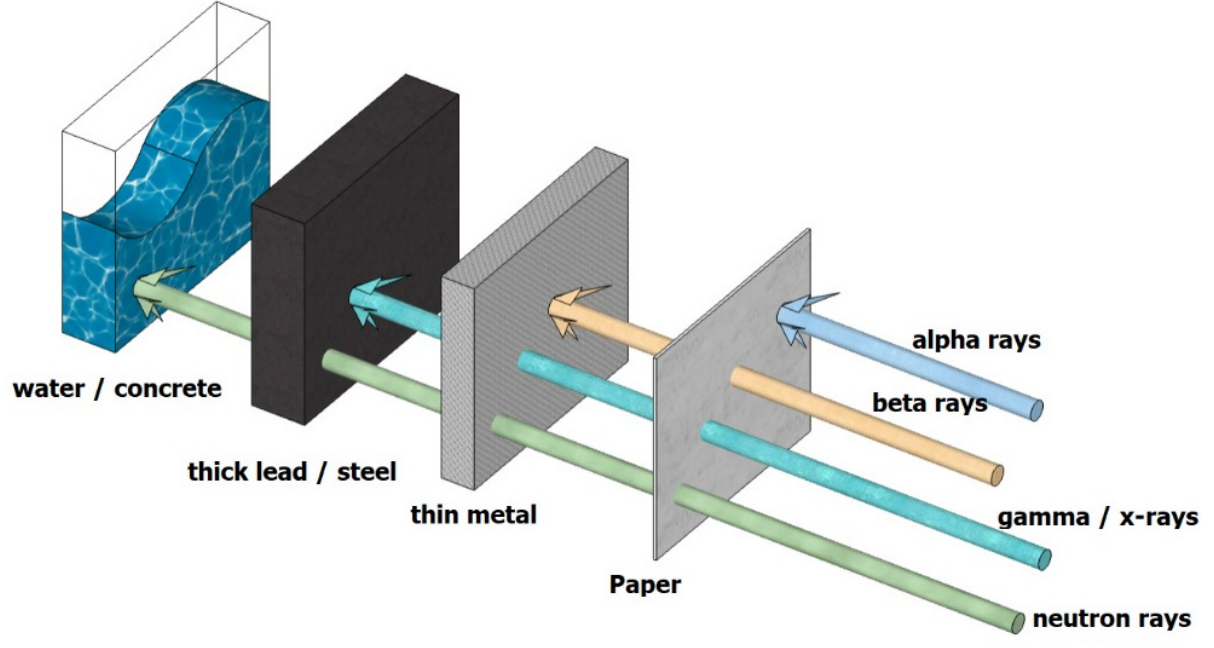
Figure 1. Type of radiations, penetrations, and their properties (Adapted with improvements from [21]).